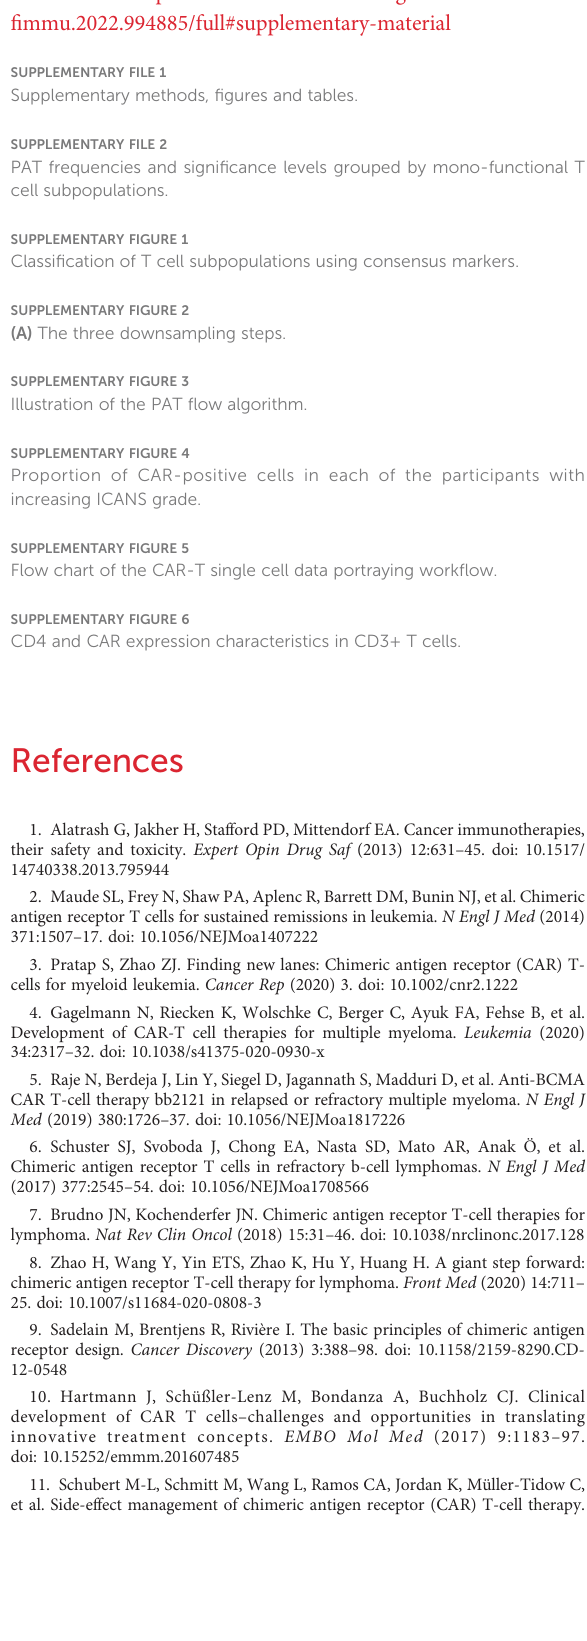
SUPPLEMENTARY FIGURE 8 Mean module overall expression level.